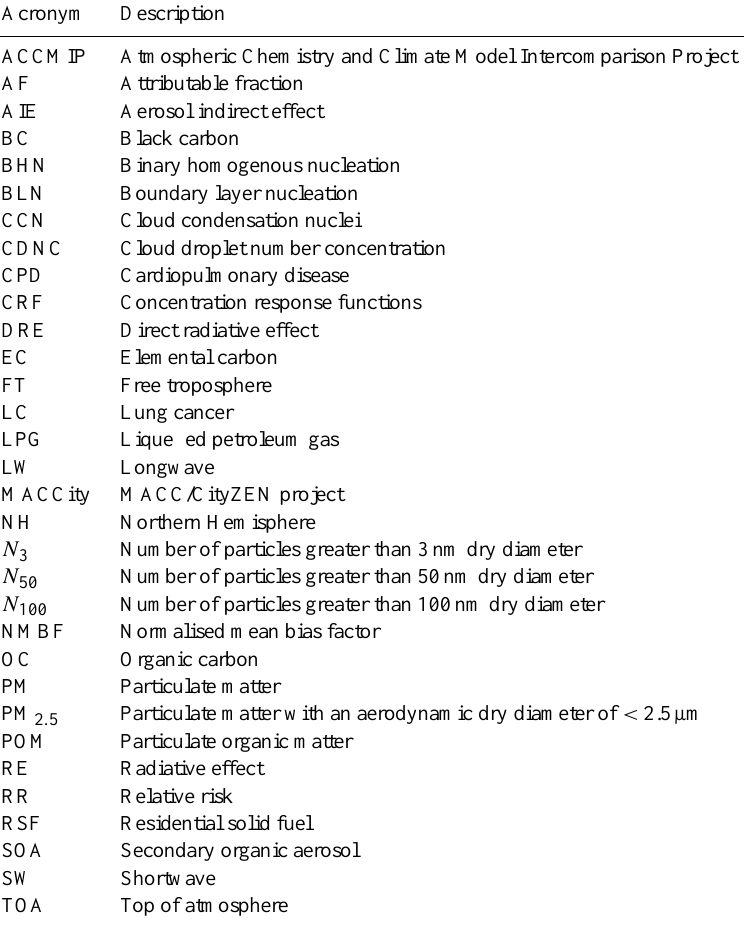
Table A1. Acronyms used in this